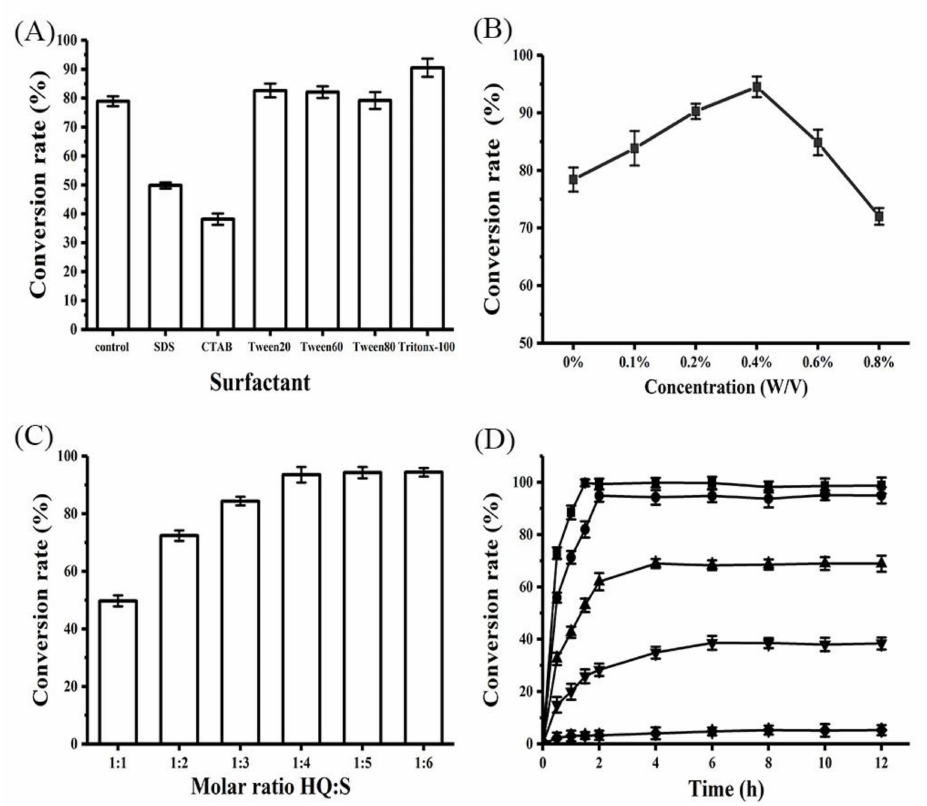
Figure 5. Effects of ( A ) surfactant, ( B ) surfactant concentration, ( C ) substrate ratio, and ( D ) substrate concentration on α -arbutin production: 125 mM (filled squares); 167 mM (filled circles); 208 mM (filled triangles); 250 mM (filled inverted triangles); 292 mM (filled diamonds). All assays were performed in triplicate in three independent experiments. Standard deviations of biological replicates are represented by error